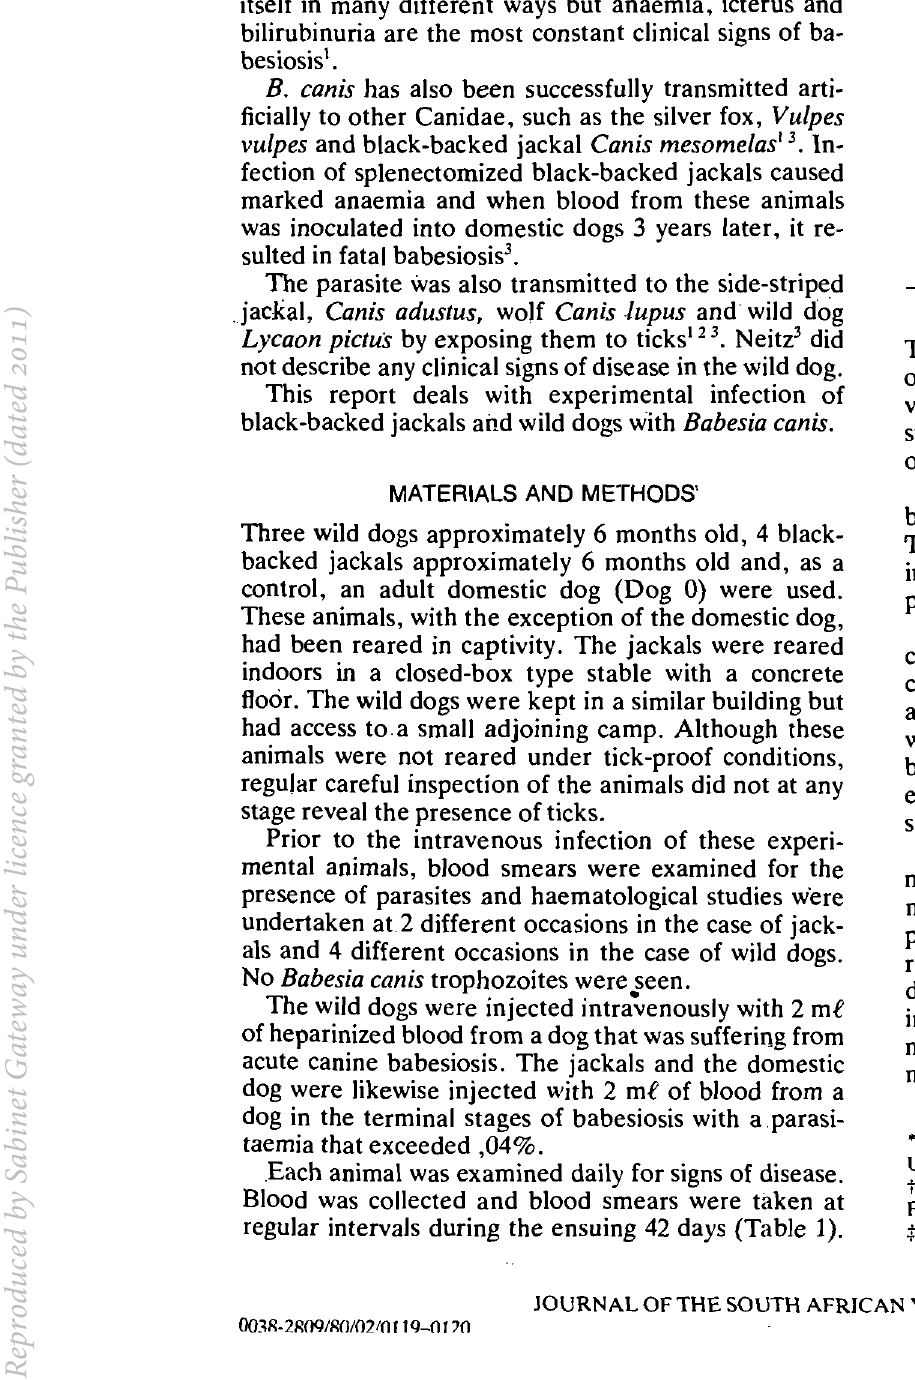
Table 1: RESULTS OF HAEMATOLOGICAL STUDIES BEFORE AND AFTER INFECTION WITH B. CANIS Days after